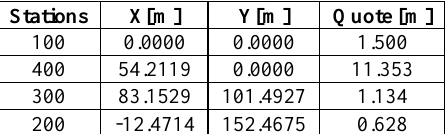
Table 2. Coordinates of the station vertices